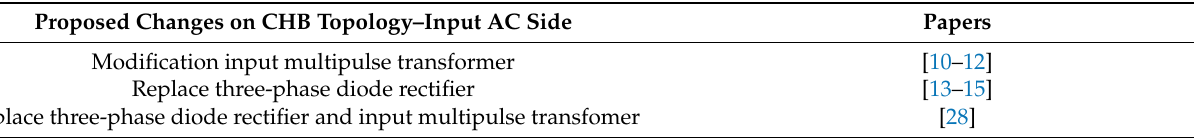
Table 1. Summary of proposals on AC drive based on CHB topology–input AC